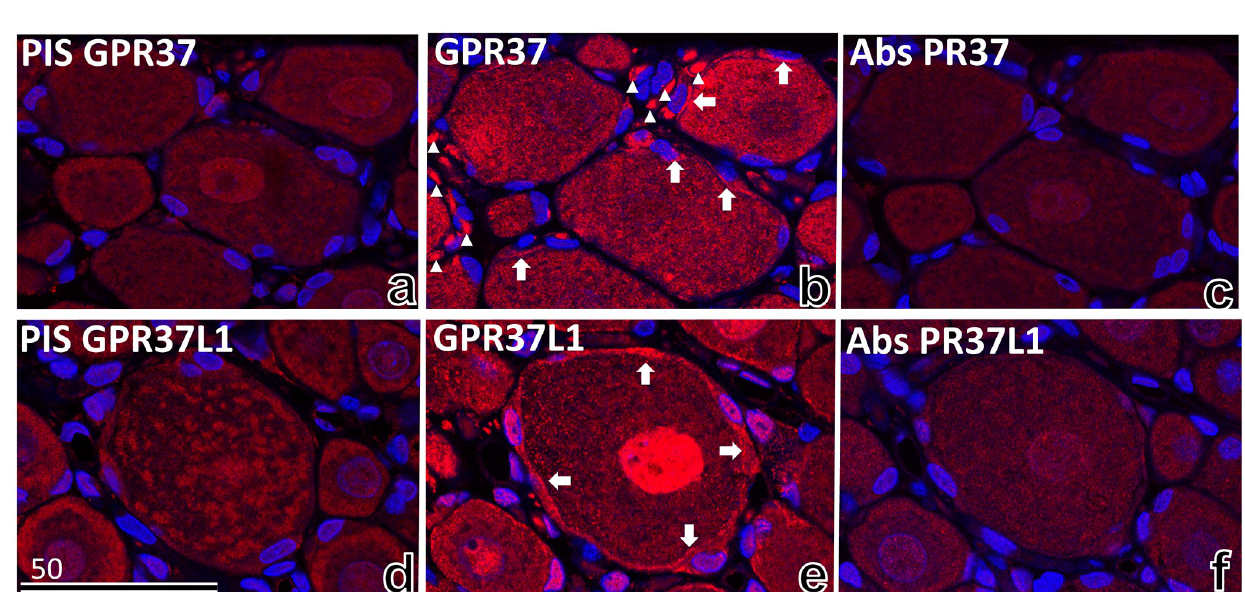
Fig 2. Validation of the antibodies to GPR37 and GPR37L1. Immunofluorescence light micrographs of 8-week-old rat DRG serial sections (a–c, d–f) stained with pre-immune serum (PIS; a, d), anti-GPR37 IgG (b), anti-GPR37L1 IgG (e), anti-GPR37 IgG absorbed with GPR37 antigen (c), or anti- GPR37L1 IgG absorbed with GPR37L1 antigen (f). GPR37 immunoreactivity (GPR37 IR) was observed mainly in the cytoplasm of satellite cells (arrows in b) and Schwan cells (arrowheads in b). GPR37L1 immunoreactivity (GPR37L1 IR) was observed mainly in the cytoplasm of satellite cells (arrows in e) and in the granular structures of neurons and satellite cells (e). Neither GPR37 nor GPR37L1 IR was observed in neighbouring sections stained with pre- immune serum (a, d) or absorbed IgG (c, f). The bars indicate the scale in micrometres.